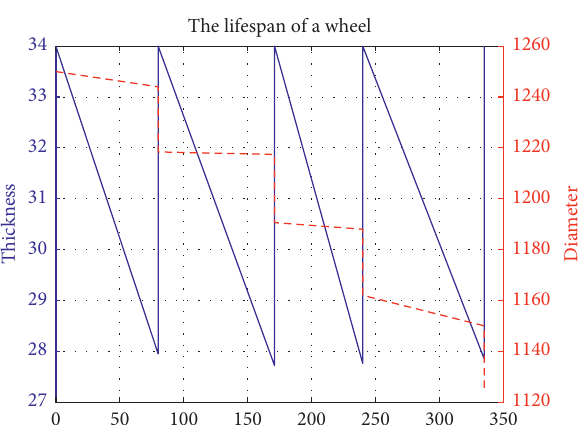
Figure 8: Wear procedure of the strategy (28,